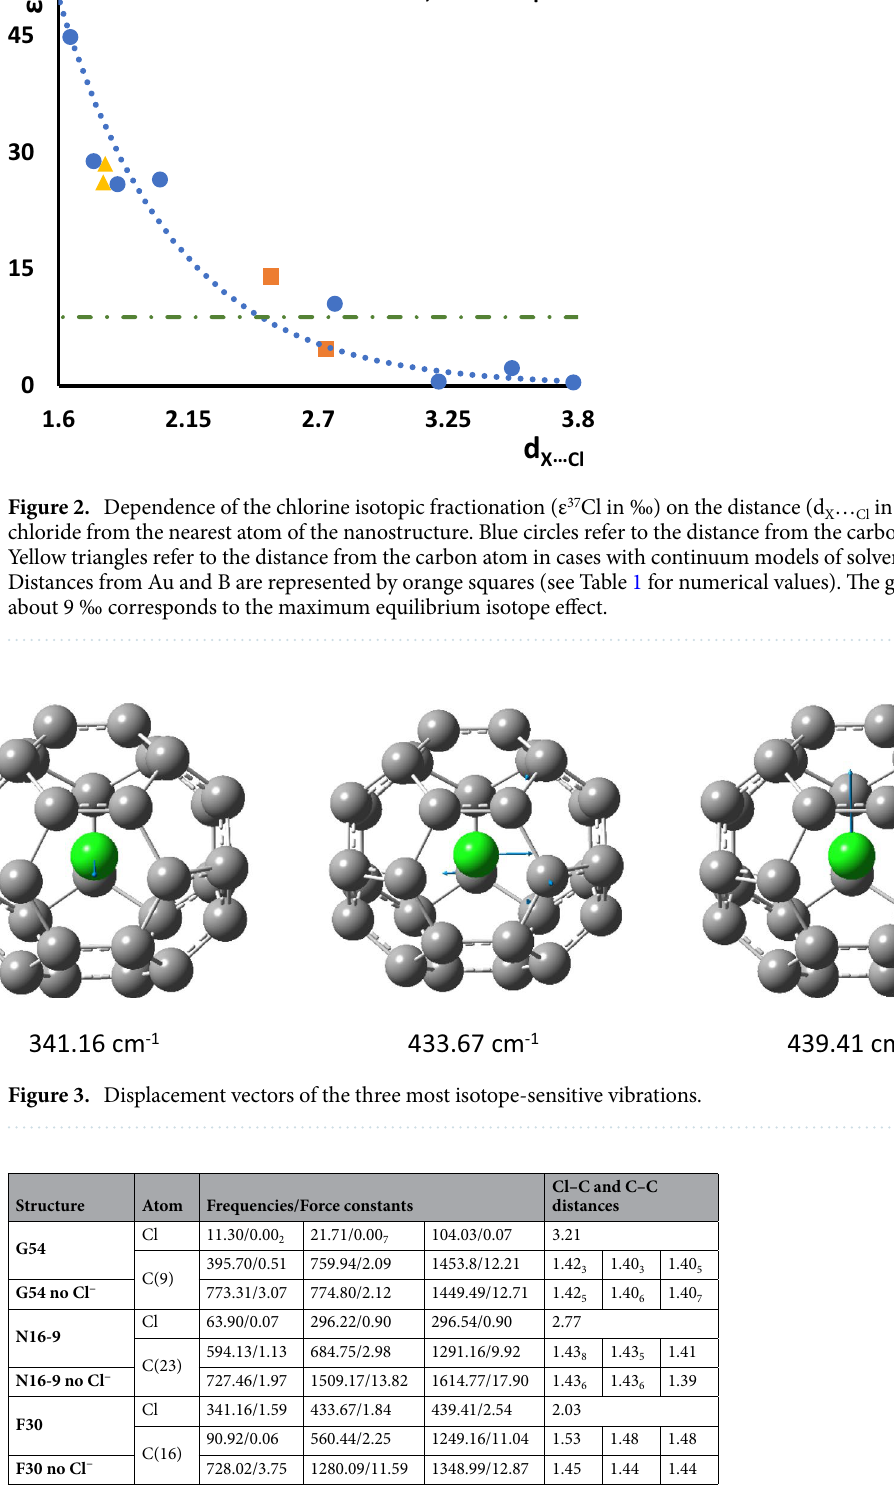
Table 2. Vibrational analysis of normal modes associated with chlorine atom and its nearest carbon neighbor. Frequencies in cm −1 , force constants in mdyne/Å, distances in Å. Numbering of carbon atoms corresponds to structures provided in the respective table of the Supplementary